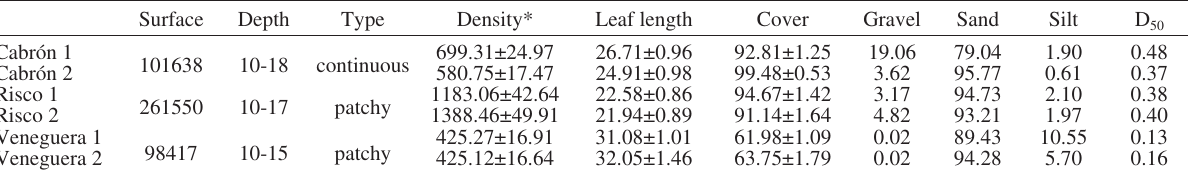
Table 1. – Physical structure of the three locations dominated by Cymodocea nodosa seagrass meadows. Surface (m 2 ), depth ranges (m) and meadow type are provided for each location. Density (number of shoots m –2 ; mean ± standard error), leaf length (cm; mean ± se), cover (%; mean ± se), gravel (%), sand (%), silt (%), and mean diameter of particles (D 50 , mm) are also provided for each site within each location.